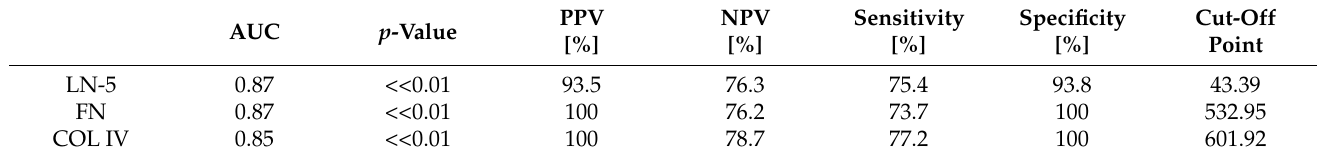
Table 4. Data on the diagnostic performance of the proteins tested.